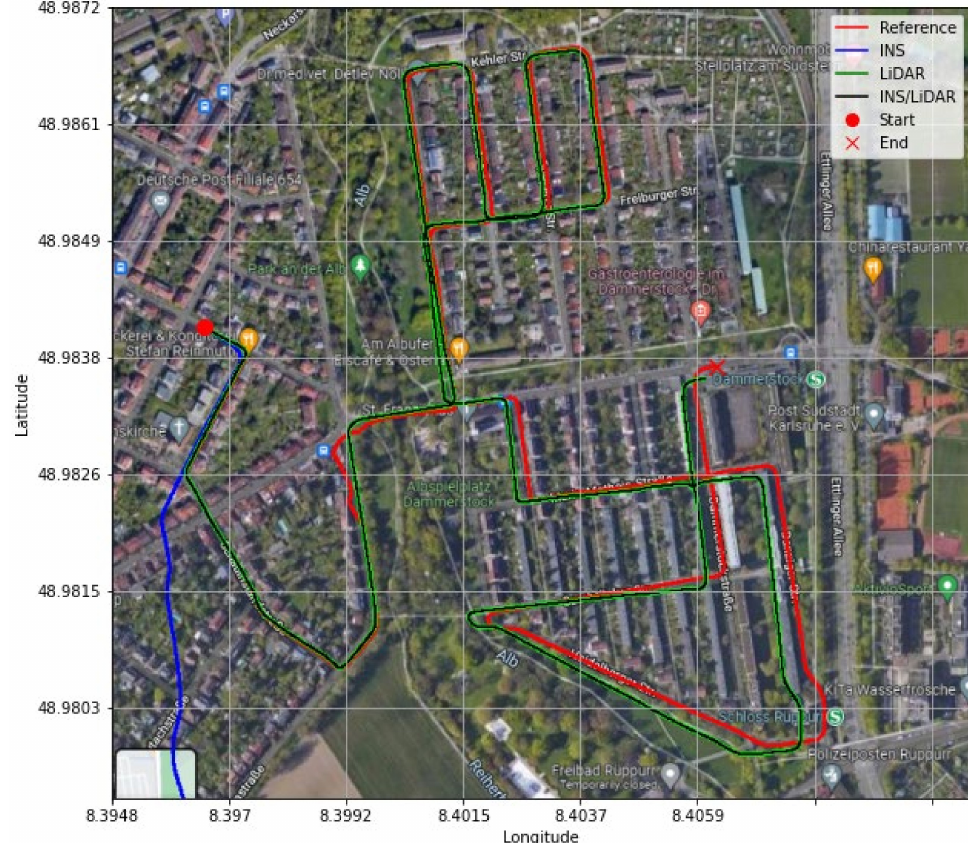
Figure 8. D-28—complete GNNS signal outage: comparison of